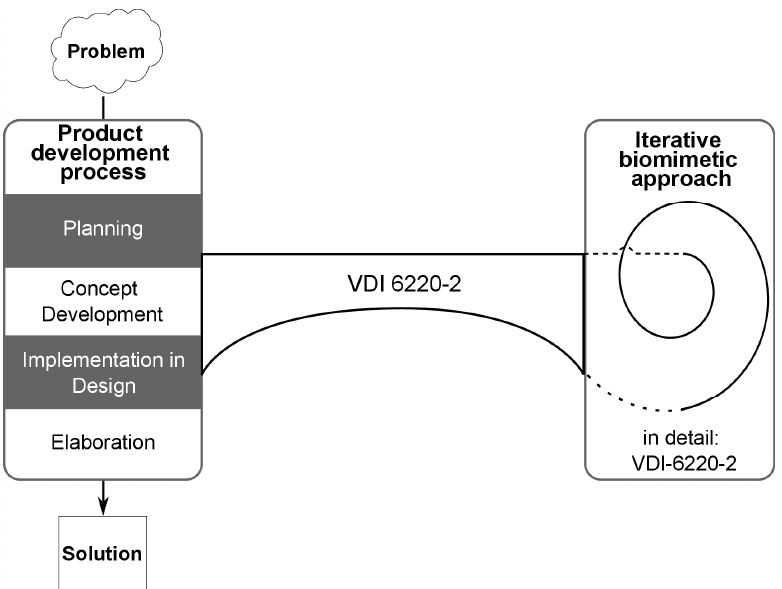
Figure 3. The biomimetic process of VDI 6220 Part 2 linked to the classical product development, for example, as in VDI 2221 Part 1 and Part 2. example, as in VDI 2221 Part 1 and Part